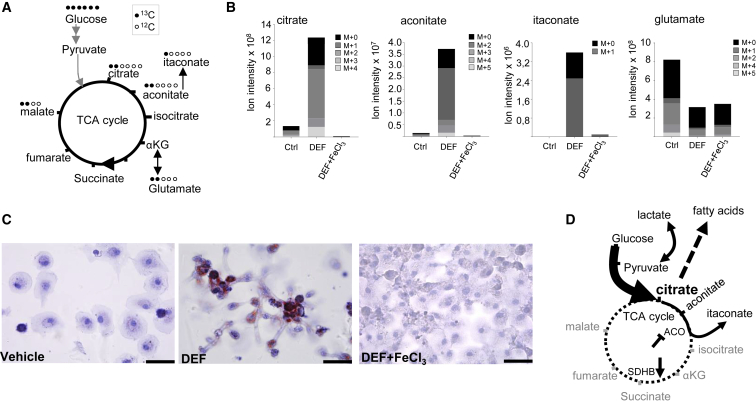
A Citrate Checkpoint Characterizes Iron-Deprived Human Macrophages(A) Diagram of uniformly labeled [U]-13C-glucose catabolism, highlighting the TCA cycle metabolites and their expected glucose-derived 13C atoms.(B) Stacked isotopologues measured by LC-MS shown for citrate, aconitate, itaconate, and glutamate in iron-deprived (DEF, 500 μM, 24 h) and rescued human macrophages with short exposure (8 h) to 200 μM ferric chloride (DEF + FeCl3); n = 6 donors.(C) Vehicle, DEF-treated, or concomitant DEF and FeCl3-treated human macrophages stained for oil red O. The results are representative of n = 4 donors.(D) Summary of the TCA cycle changes due to iron deprivation in human macrophages. Citrate accumulation resulting from aconitase (ACO) inhibition and SDHB downregulation and the fate of citrate-derived metabolites are illustrated. Dashed circle represents inhibited TCA cycle activity. αKG, α-ketoglutarate.Scale bars, 40 μm.See also Figures S3 and S4.